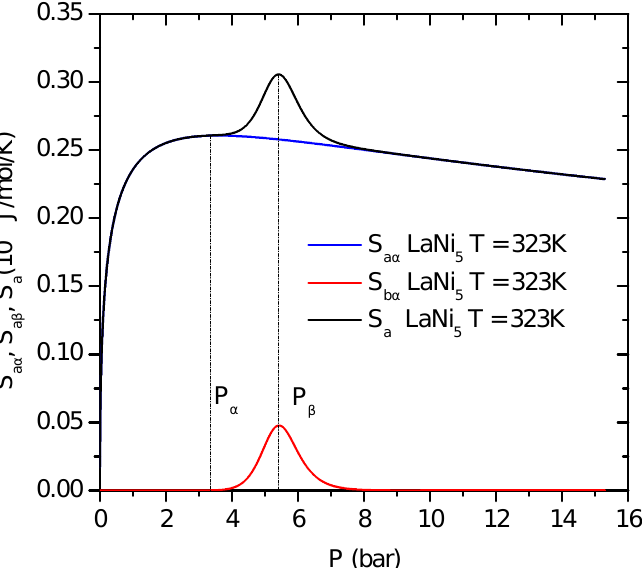
Figure 11. Evolution of the absorption entropy of the α phase (Equation (32)), the β phase (Equation (33)) and the overall according to the pressure at T = 323 K (Equation (31)).